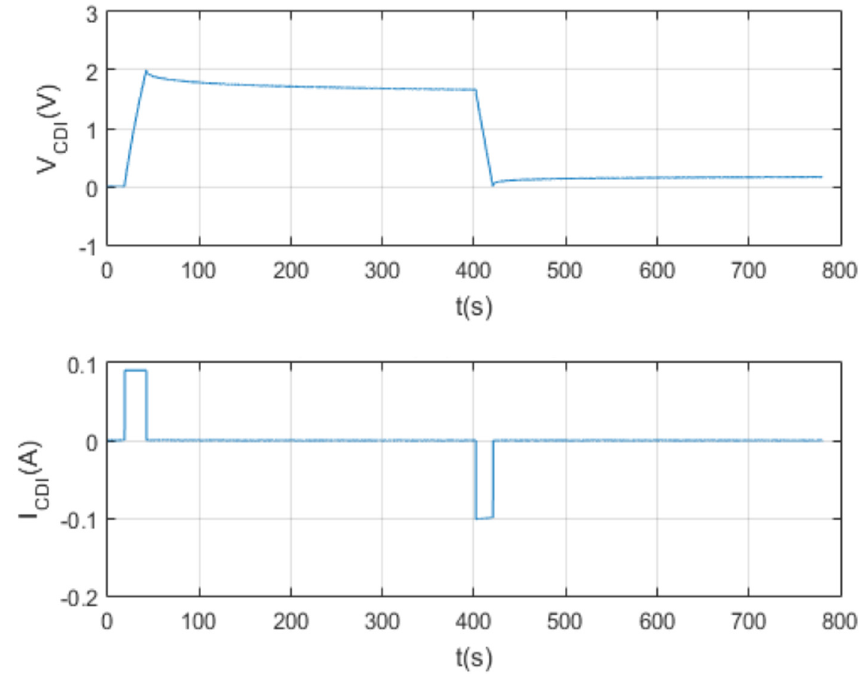
Figure 20. Charge and discharge test for the 1 F supercapacitor with other input setpoints. Table 5. Data programmed to characterize the CSP-CDI system.